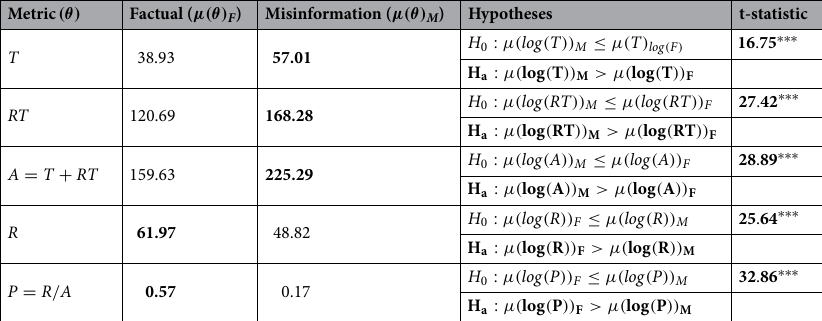
Table 1. Results of hypothesis testing for difference in means between the two groups of users along the factuality dimension for various metrics. Significant values are in bold. Factual users ( F ) have high factuality scores ( f l ≥ 0.6 ) while misinformation users ( M ) have low scores ( f l ≤ 0.4 ). Metrics include: number of tweets ( T ) and retweets ( RT ) generated by the user, the overall activity ( A ), number of times the user is retweeted ( R ) and retweet power ( P ) which is the ratio of number of times retweeted and activity. We performed t -tests to assess the statistical significance of difference between the two distributions after log transforming the variables. ***Denotes a statistically significant difference between the means of the two distributions with p-value < 0.001 .